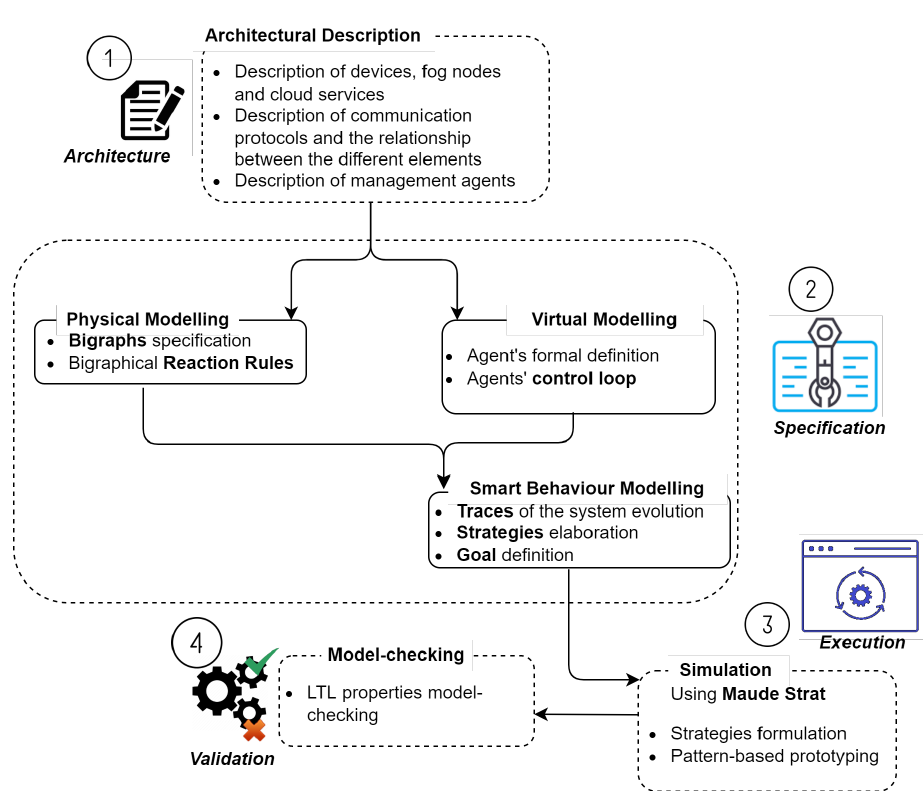
Figure 1. Specification and analysis of fog systems: our